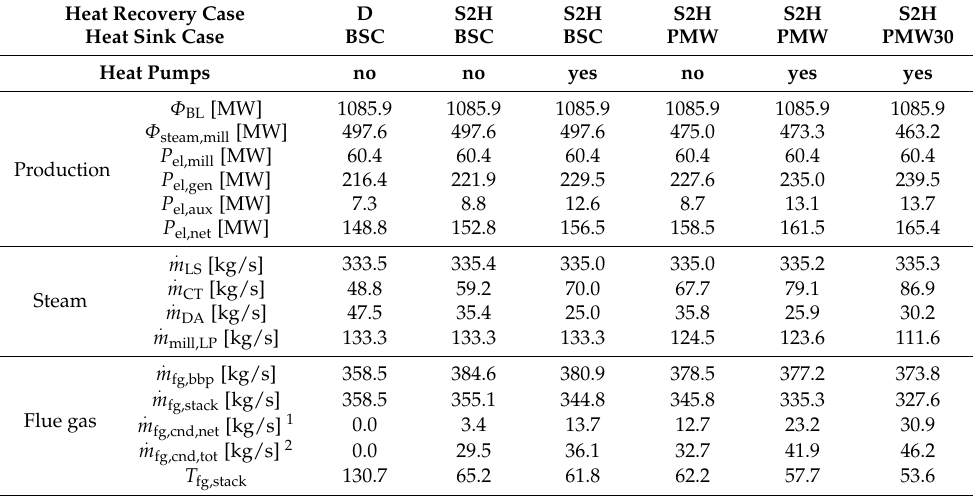
Table 4. Simulation results for S2H type heat recovery with different heat sink cases.